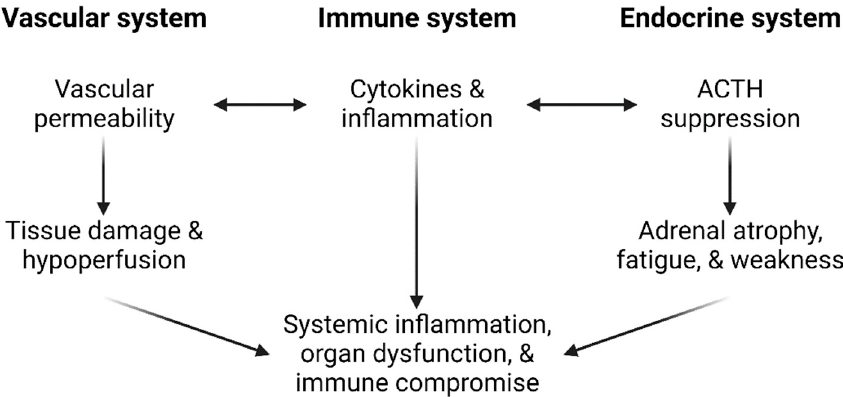
Figure 3. Vascular and endocrine “vicious cycles” associated with myalgic